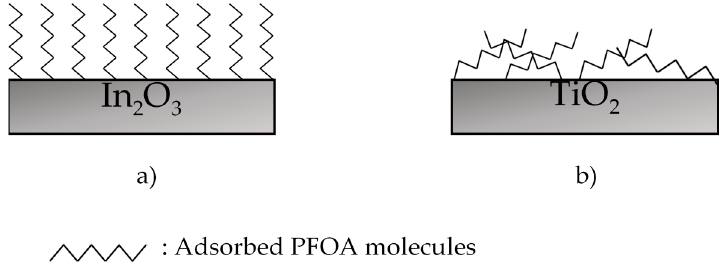
Figure 7. Adsorption modes of PFOA onto In 2 O 3 ( a ) and TiO 2 ( b